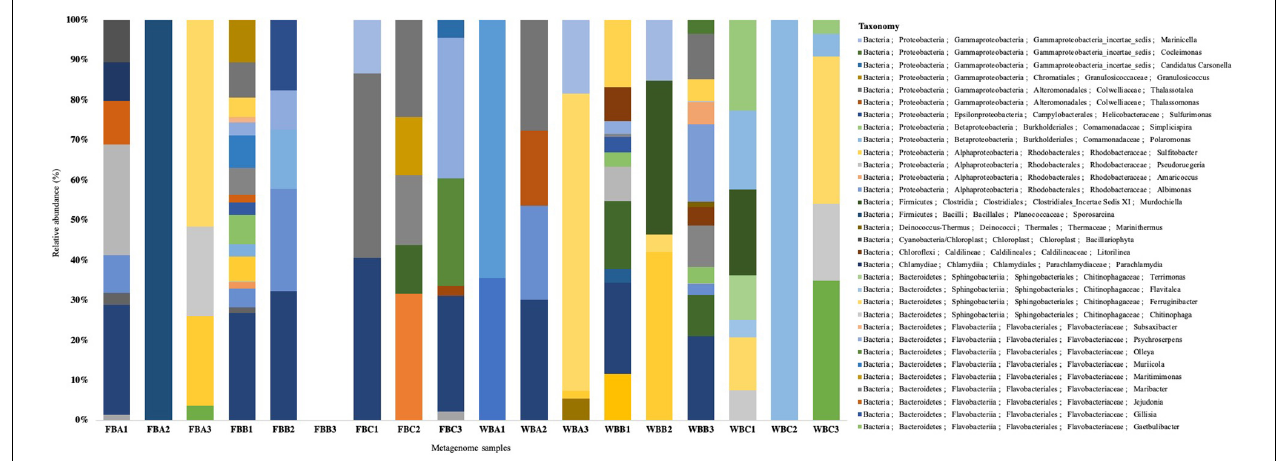
FIGURE 2 | Relative abundances of the taxonomic groups assigned to the SSU rRNA, reconstructed from metagenomes.